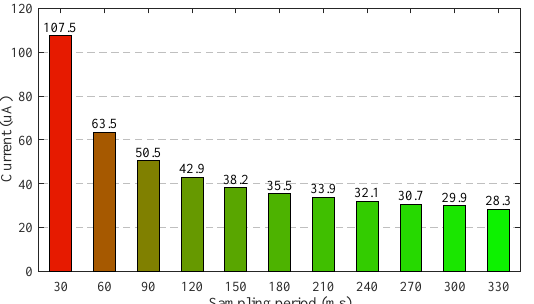
Figure 22. The measured currents of sensor at different sampling